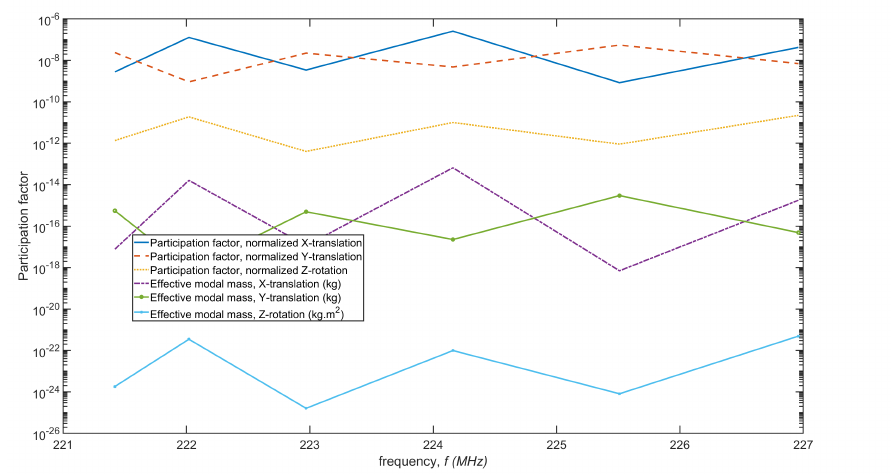
Figure 9. Eigenfrequency, participation factors, and effective modal masses of the first six modes of BAW piezoelectric in eigenfrequency evaluation.